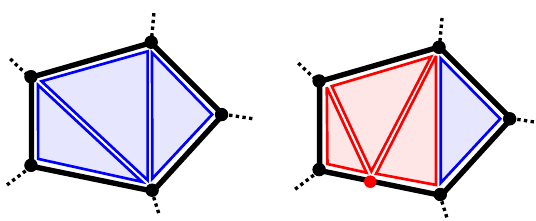
Figure 10 . Illustrative example of a non-minimal triangulation of a non-simplicial cone. In this example, we consider a 3-dimensional fan and draw its intersection with the unit-sphere S 2 . Note that the vertices correspond to the rays and lines to dimension-2 surfaces. Simplicial cones have three rays and thus three vertices. On the left hand, we draw in blue a minimal triangulation. On the right hand, we draw how a redundant ray, drawn in red, leads to a non-minimal triangulation. Geometry